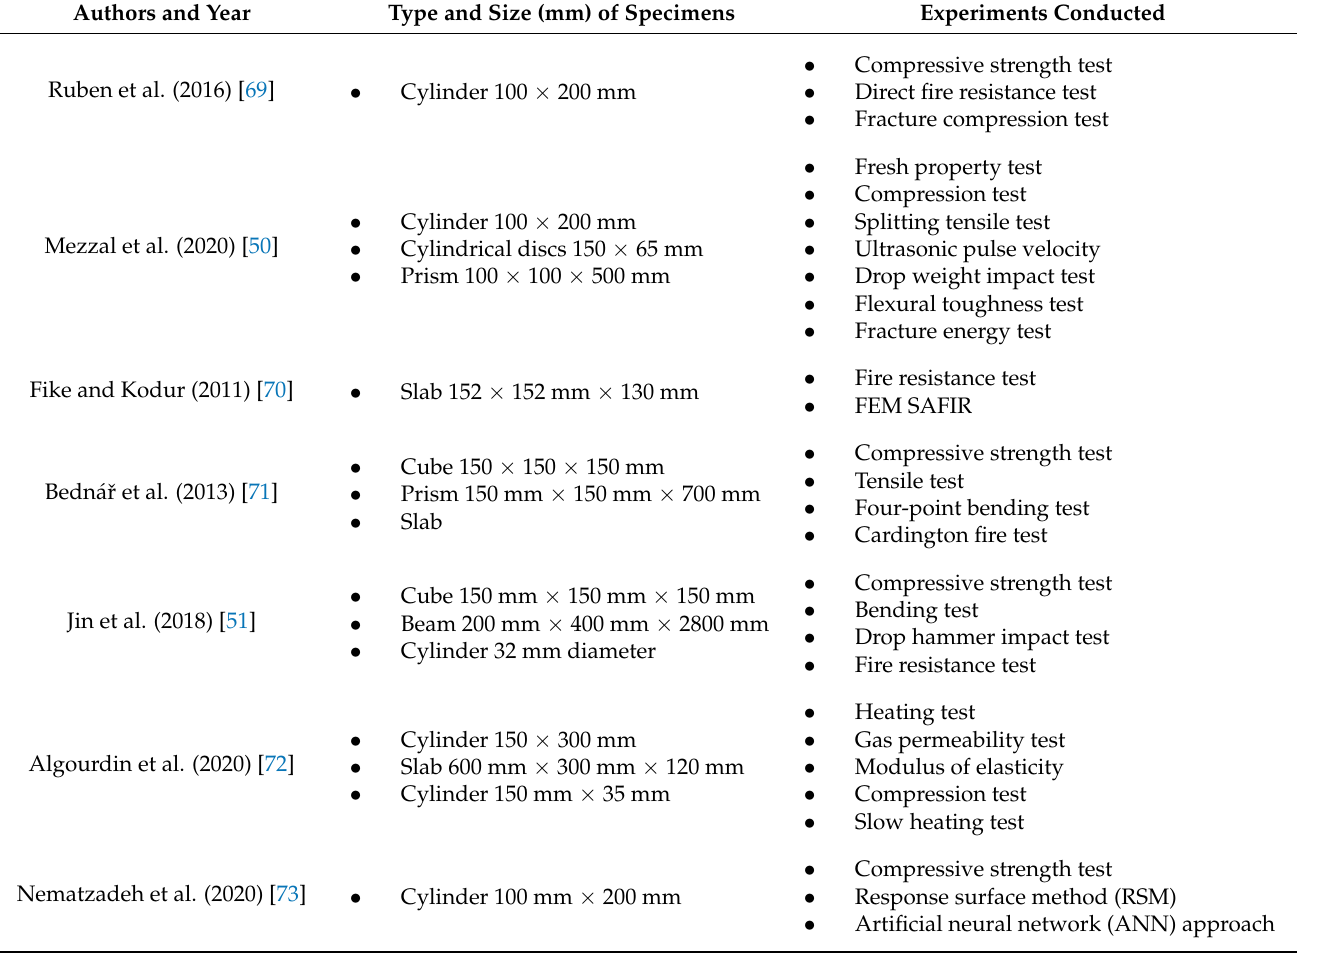
Table 2. The majority of experiments on the fire-resistant properties of steel